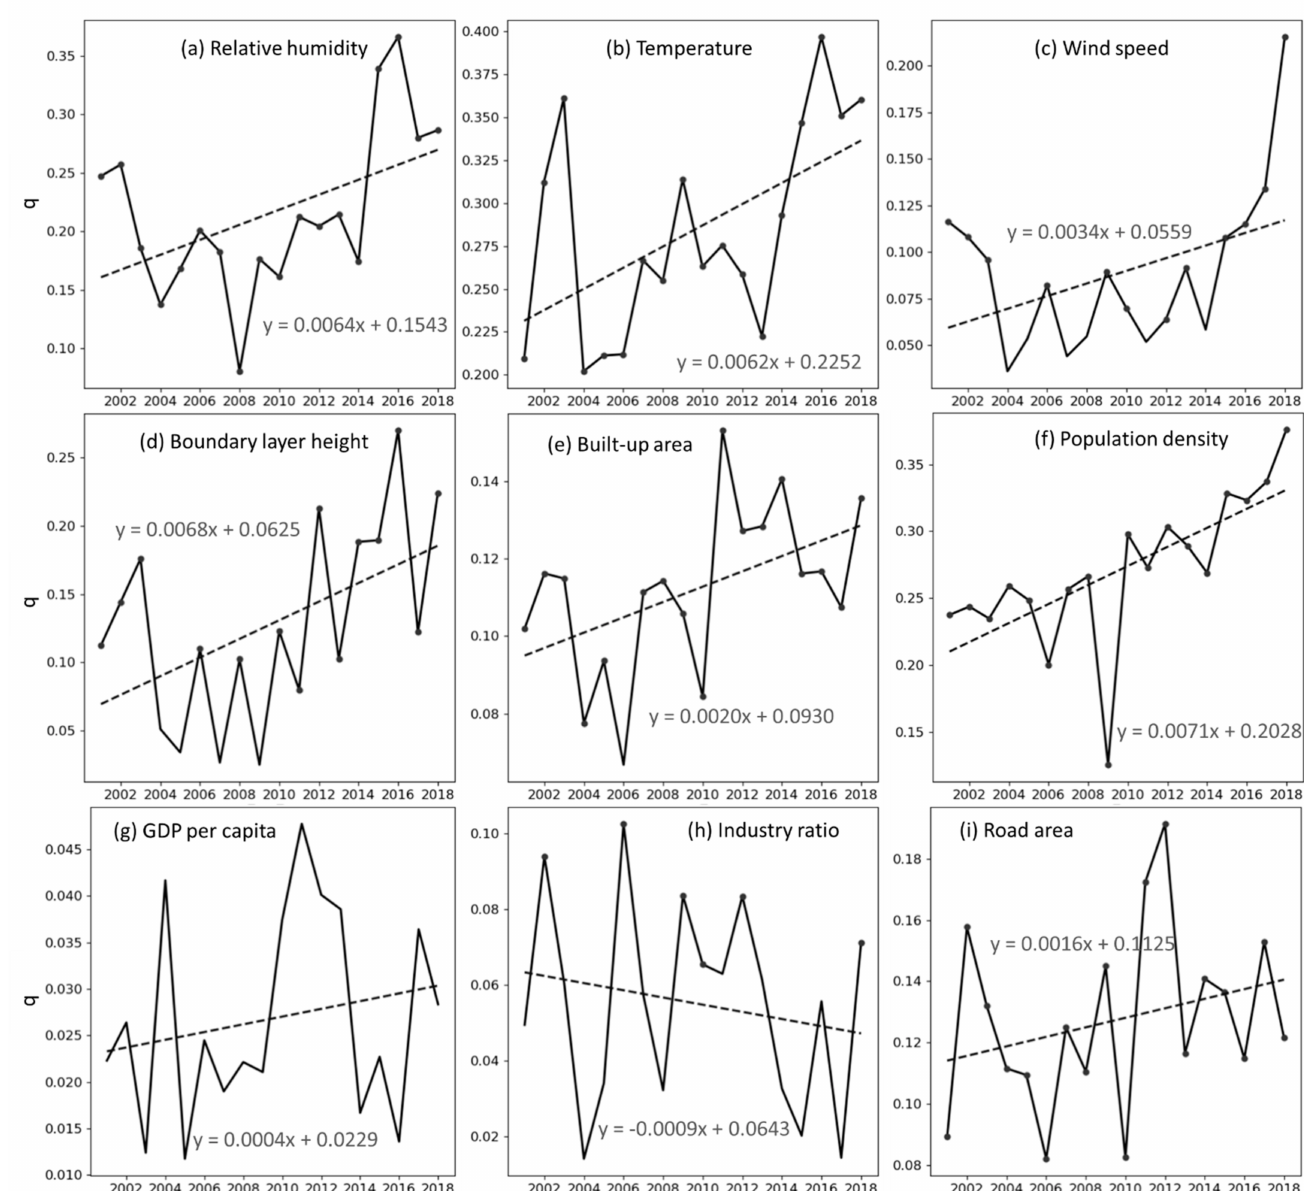
Figure 6. Scatterplots of power of determinant values (q) with their linear trend lines (dashed line) for each influencing factor from 2001 to 2018. The dot indicates a p -value below